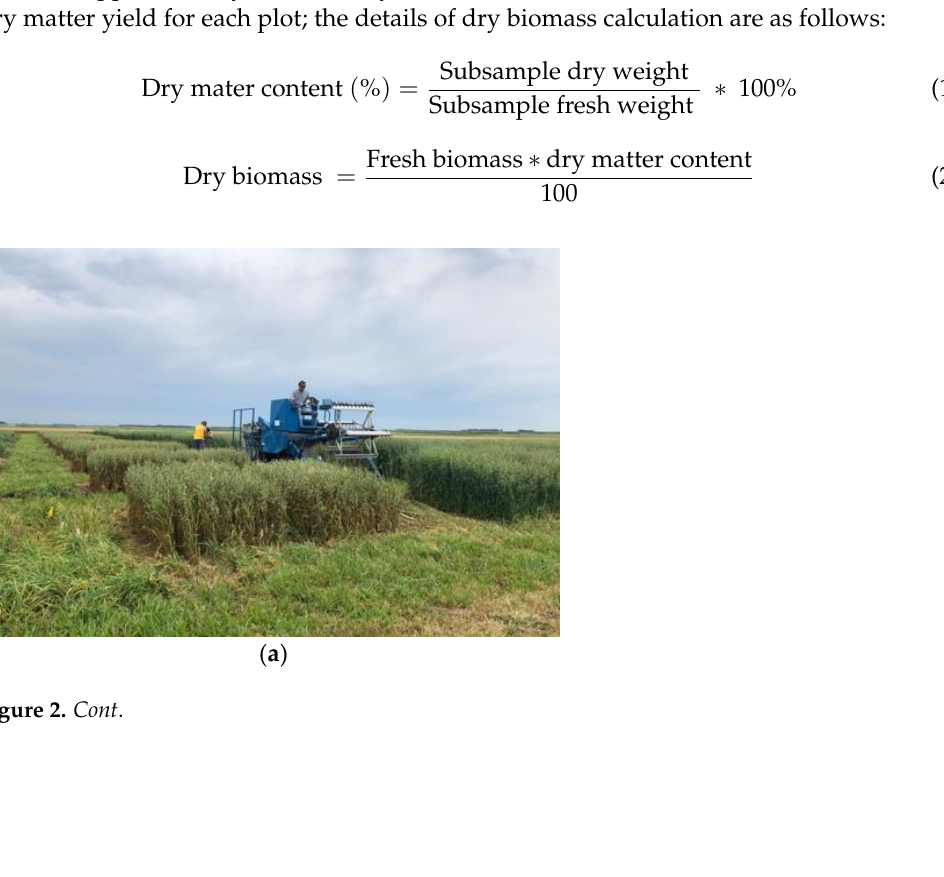
Figure 1. Three different experimental locations (South Shore, Beresford, and Volga) in South Dakota.